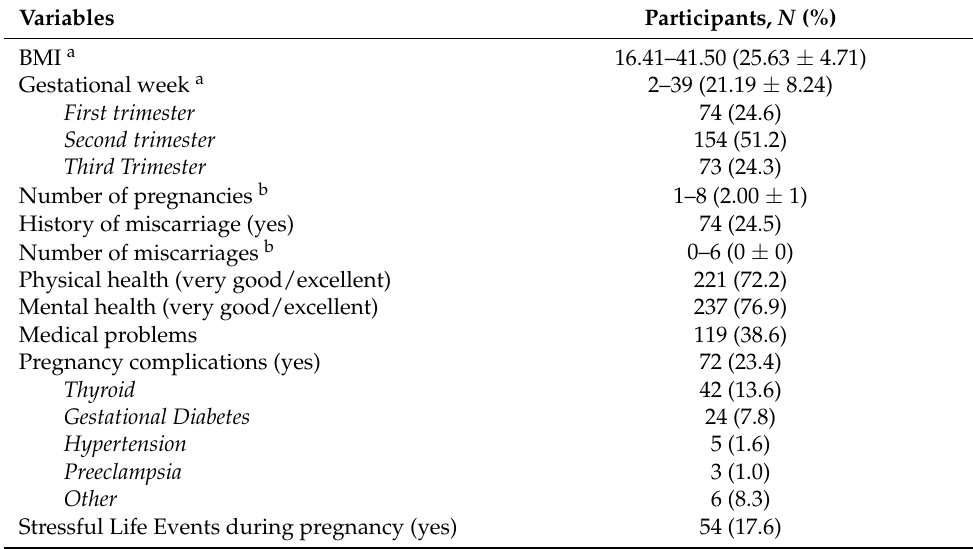
Table 2. Health status and obstetric information ( N =